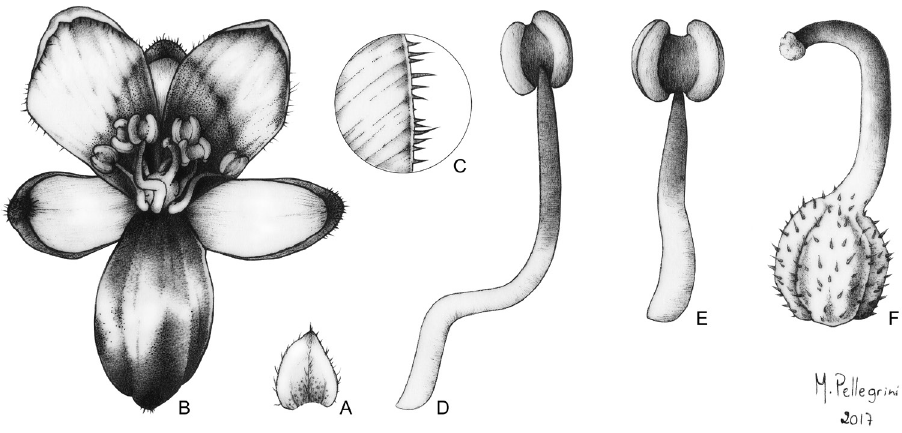
Figure 11. Line drawings of Siderasis spectabilis M.Pell. & Faden. A bracteole B front view of a bisexual flower, showing the petals ciliate with non-moniliform hairs C detail of the petal margin, showing the non-moniliform hairs D lower stamen, showing the rectangular anther connective E upper stamen, show- ing the quadrangular anther connective F Detail of the gynoecium, showing the velutine ovary and bent style. Line drawings by M.O.O.